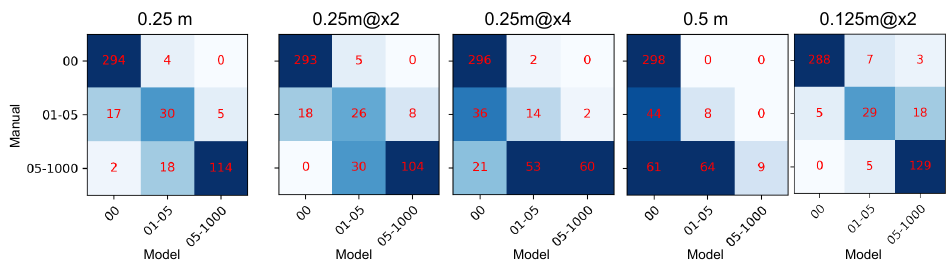
Figure 6. Confusion matrices of the block diagrams shown in Figure